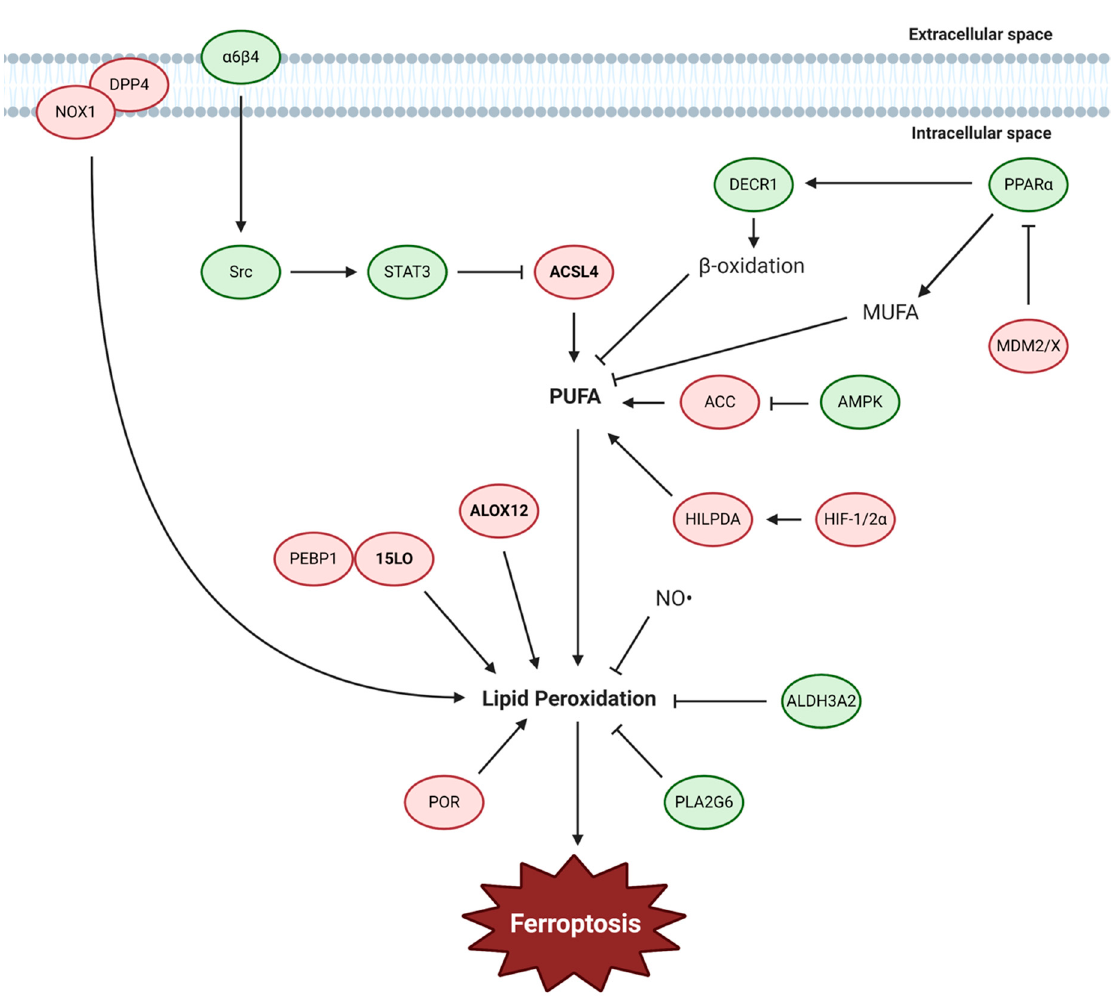
Figure 3. Lipid metabolism regulates ferroptosis. The major stages of lipid metabolism that regulate ferroptosis are the generation of PUFA and the induction of lipid peroxidation. ACSL4 is the major enzyme that generates PUFAs which drive ferroptosis. In the case of lipid peroxidation, ALOX and other factors can contribute to the production of lipid peroxides. Ferroptosis inhibiting and inducing factors are indicated in green and red, respectively. (Abbreviations: 15LO, 15-lipoxygenase; ACC, acetyl-CoA carboxylase; ACSL4, acyl-CoA synthetase long-chain family member 4; ALDH3A2, aldehyde dehydrogenase 3 family member A2; ALOX, arachidonate 5-lipoxygenase; AMPK, 5 ′ AMP-activated protein kinase; DECR1, 2,4-dienoyl-CoA reductase 1; DPP4, dipeptidyl-peptidase 4; HIF-1/2 α , hypoxia-inducible factor 1/2 α ; HILPDA, hypoxia inducible lipid droplet associated; MDM2/X, murine double minute family members 2/X; MUFA, monounsaturated fatty acids; NO, nitrogen oxide; NOX1, NADPH oxidase 1; PEBP1, phosphatidylethanolamine binding protein 1; PLA2G6, phospholipase A2 group VI; POR, P450 oxidoreductase; PPAR α , peroxisome proliferator-activated receptor alpha; PUFA, polyunsaturated fatty acids; STAT3, signal transducer and activator of transcription 3).